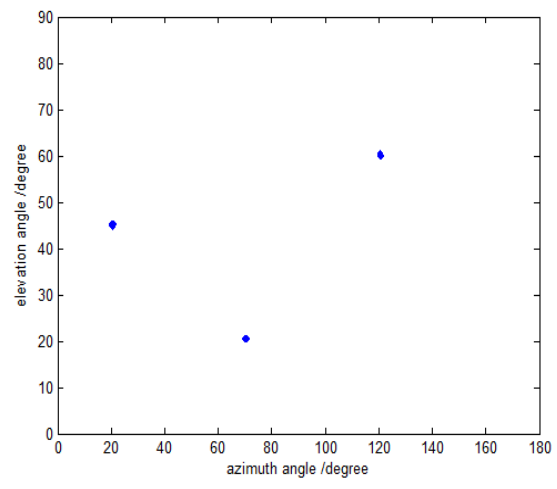
Figure 3. The polarization estimation with fixed SNR 15 dB and snapshot number 500.